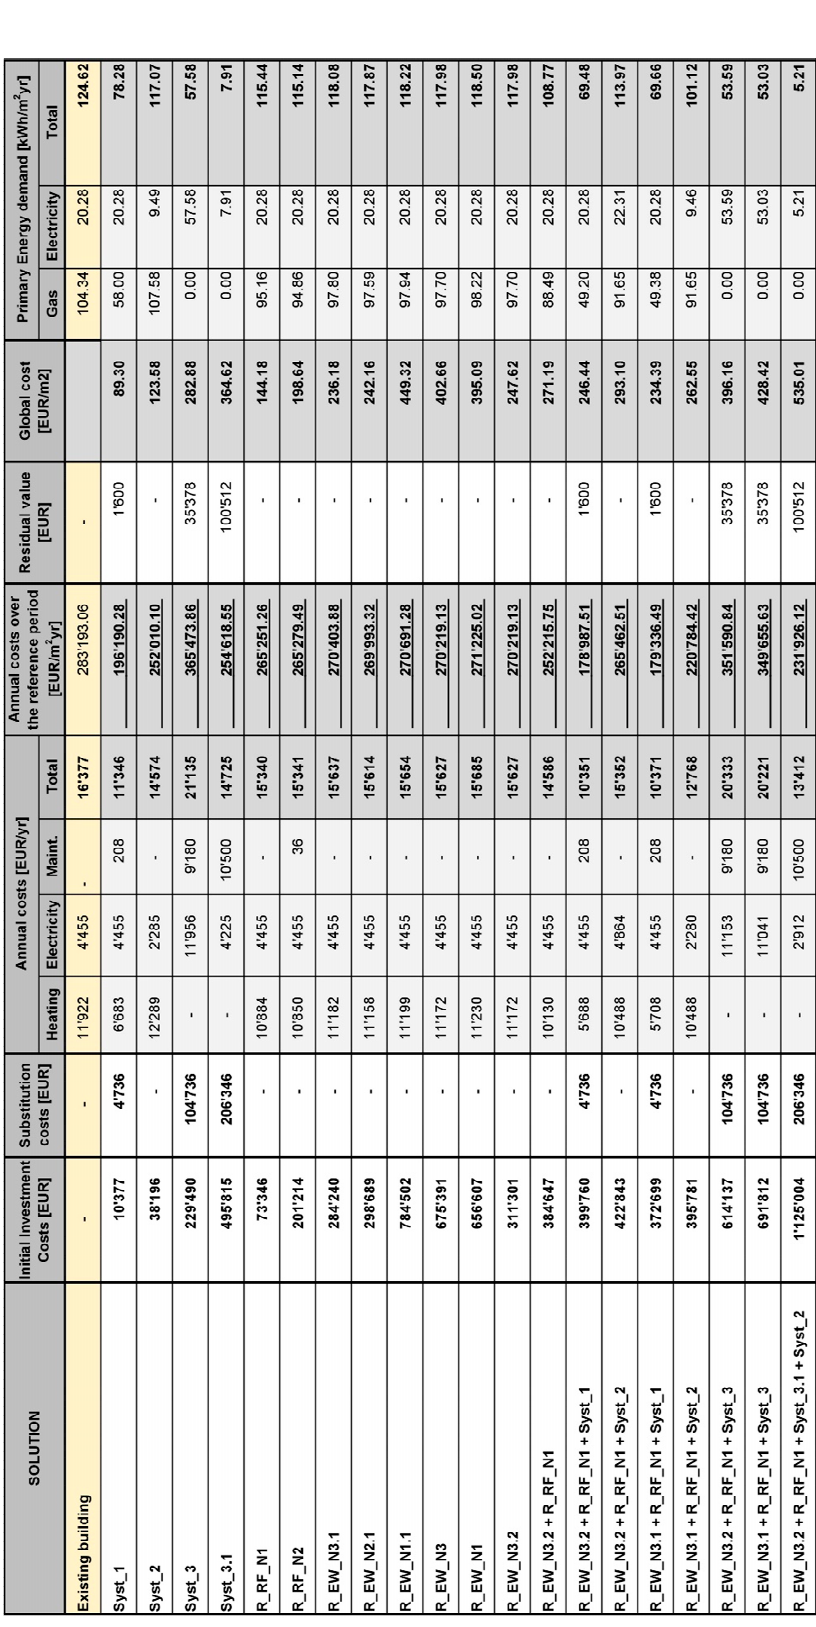
Figure A5. Summary table of cost-optimal methodology for financial scenario with discount rate equal to 4% for Rodari school.